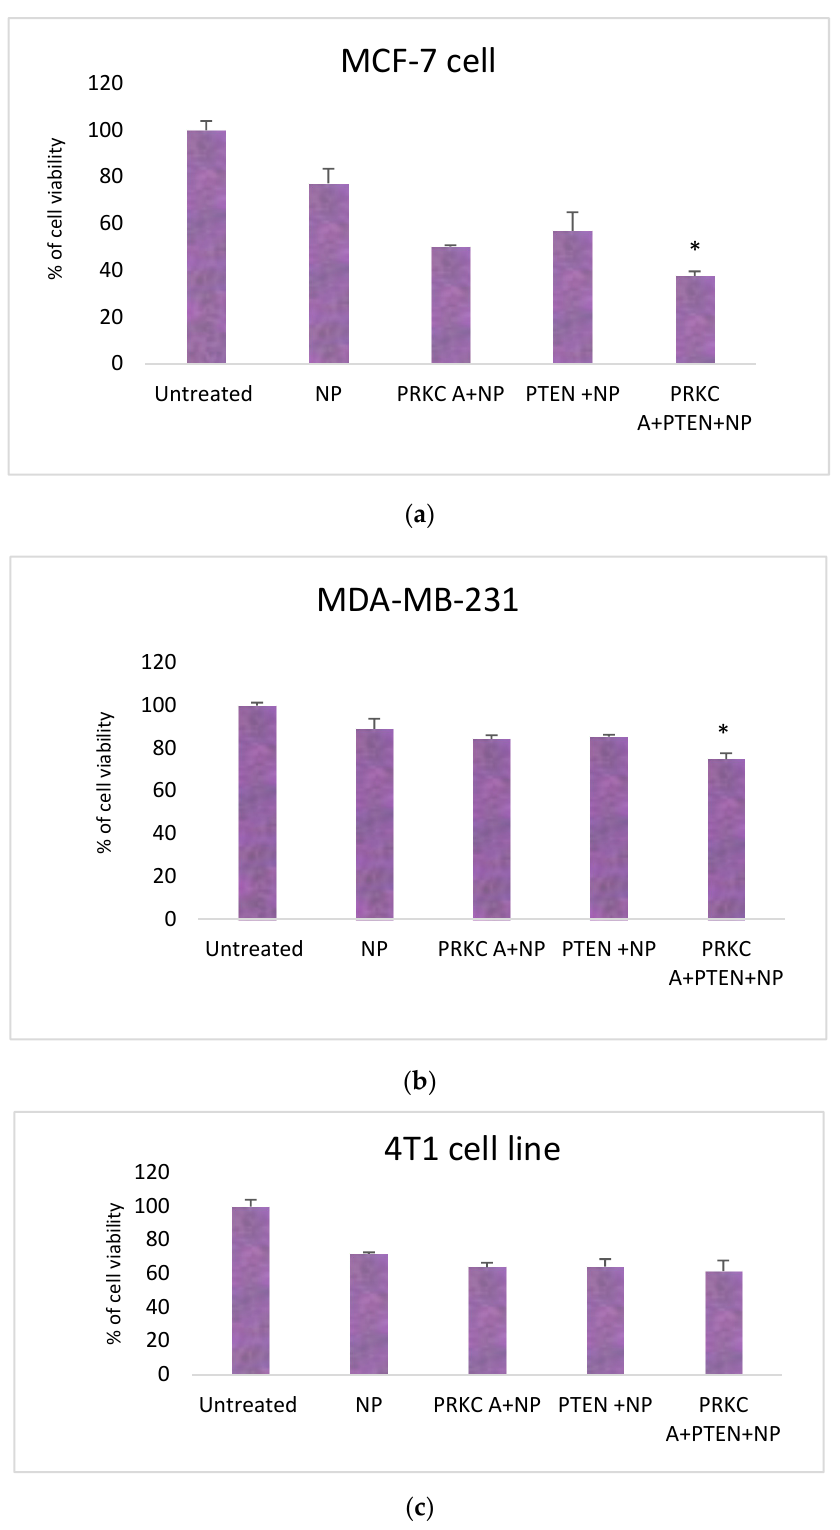
Figure 3. Cell viability assessment of PRKCA siRNA and PTEN plasmid delivery in ( a ) MCF-7 ( b ) MDA-MB-231 and ( c ) 4T1 cells treated with PRKCA+NPs, PTEN+NPs and PRKCA+PTEN+NPs formulations for 48 hr. The experiments were performed three times in each of the cell lines and values were presented as mean ± SD of triplicates in MTT assay. * p < 0.05 for PKCA+PTEN+NP compared to PRKCA+NPs and or PTEN+NPs treated cells.